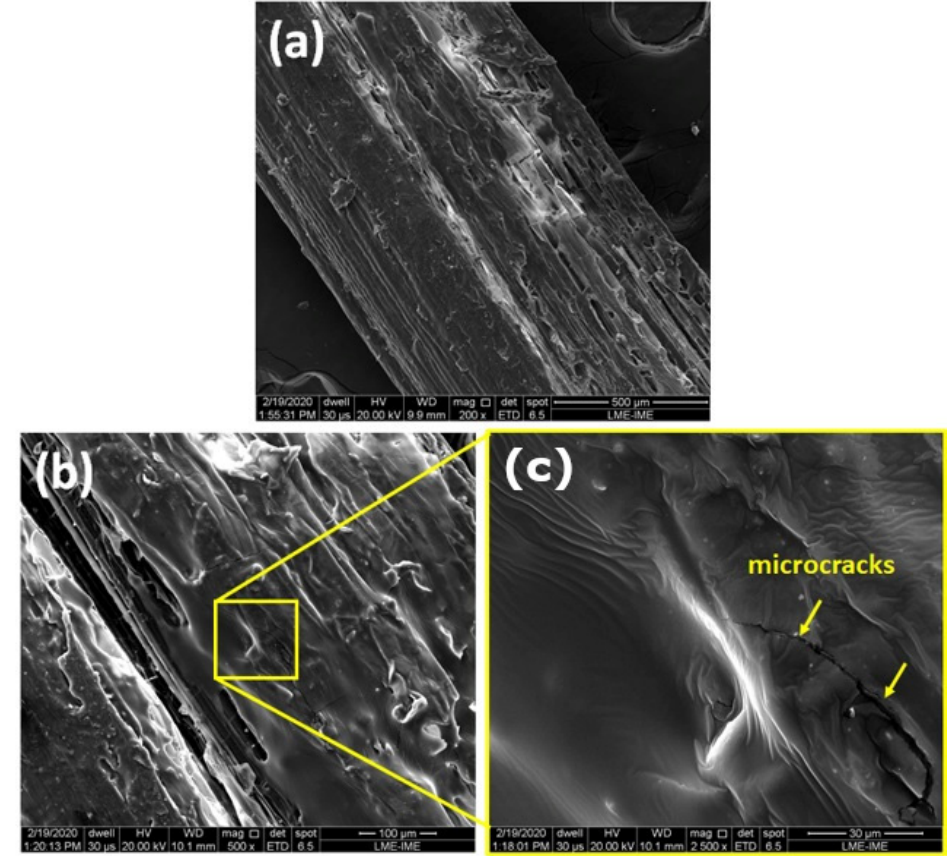
Figure 5. SEM images of the CM sedge fibers with magnifications of ( a ) 200×; ( b ) 500×; ( c ) 2500×.